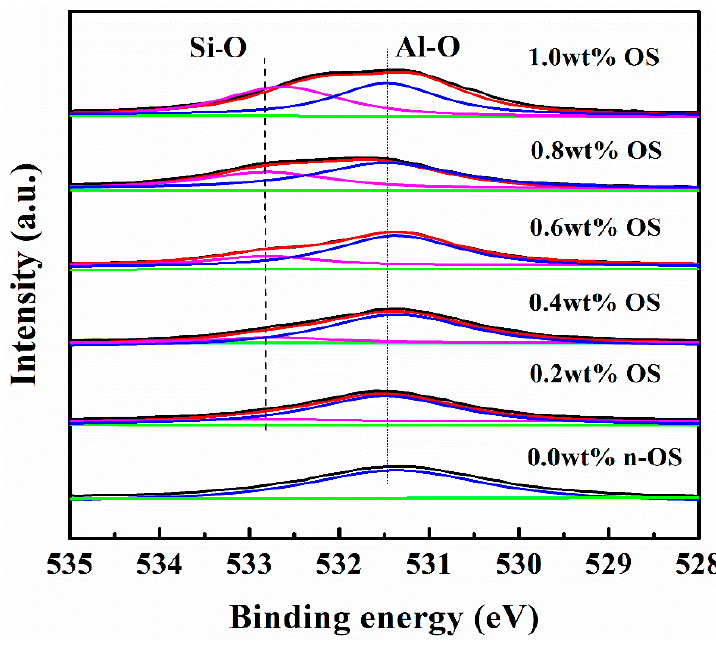
Figure 4. O1s of various OS-modified AlN powders.